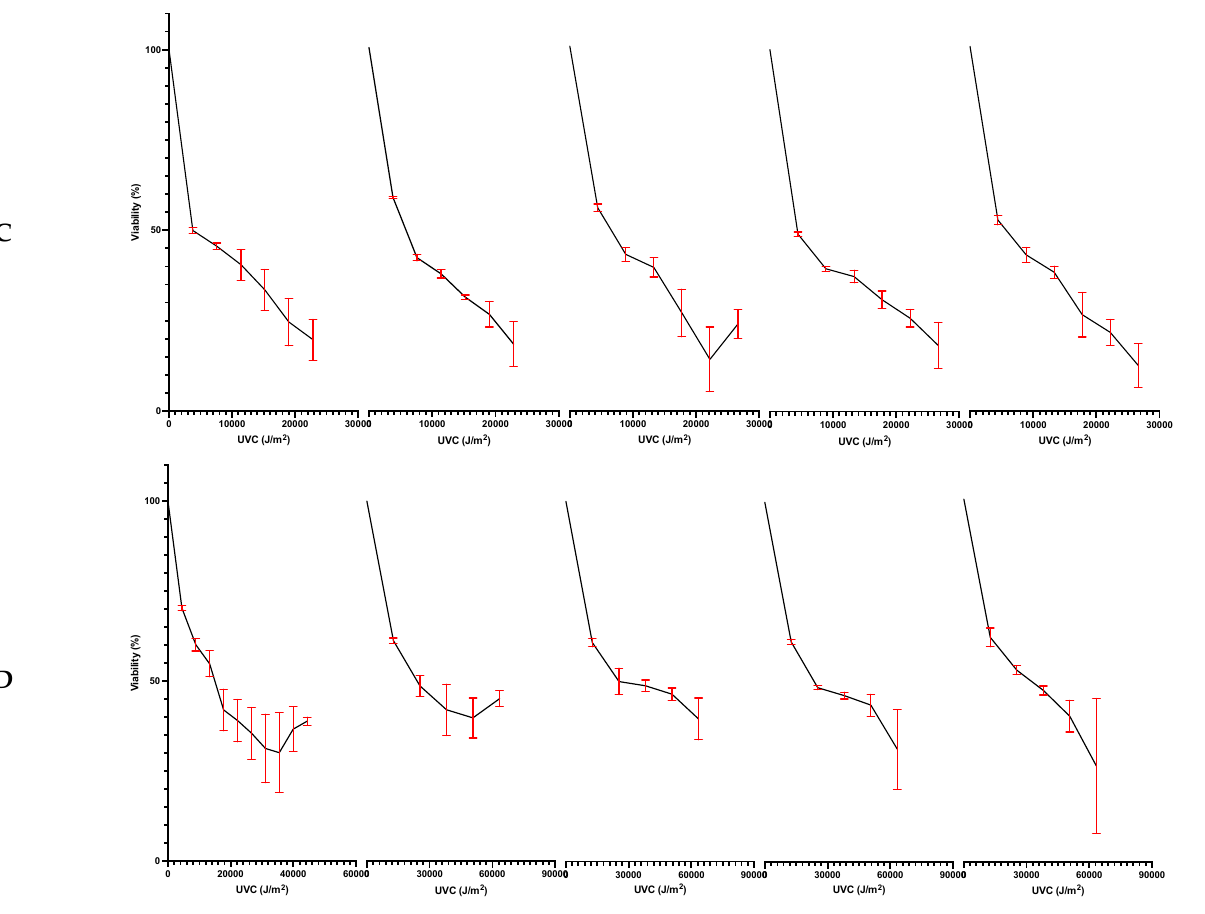
Figure 4. ( A ) Viability of E. coli ATCC 25922 over successive freeze-thaw cycles from an average starting concentration of 7.42 × 10 8 CFU/mL when subjected to UVC irradiation ranging from 0–5285 J/m 2 . ( B ) Viability of E. coli DSM 9079 over successive freeze-thaw cycles from an average starting concentration of 1.84 × 10 8 CFU/mL when subjected to UVC irradiation ranging from 0–5285 J/m 2 . ( C ) Viability of P. fungorum DSM 17061 over successive freeze-thaw cycles from an average starting concentration of 3.28 × 10 8 CFU/mL when subjected to UVC irradiation ranging from 0–25,371 J/m 2 . The error bars depict +/ − one standard deviation about the mean for each test sample. ( D ) Viability of D. radiodurans ATCC 13939 over successive freeze-thaw cycles from an average starting concentration of 3.92 × 10 7 CFU/mL when subjected to UVC irradiation ranging from 0–63,428 J/m 2 .